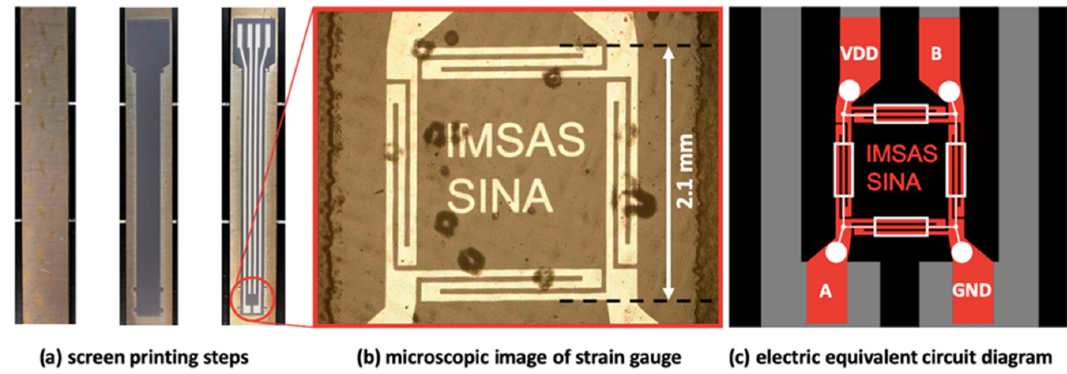
Figure 1. Design overview: ( a ) an aluminum sheet, an aluminum sheet with ground insulation, a sheet with screen printed insulation and a screen printed conductor; ( b ) a magnified cutting of the real sensor; ( c ) a circuit diagram of the full bridge strain gauge.